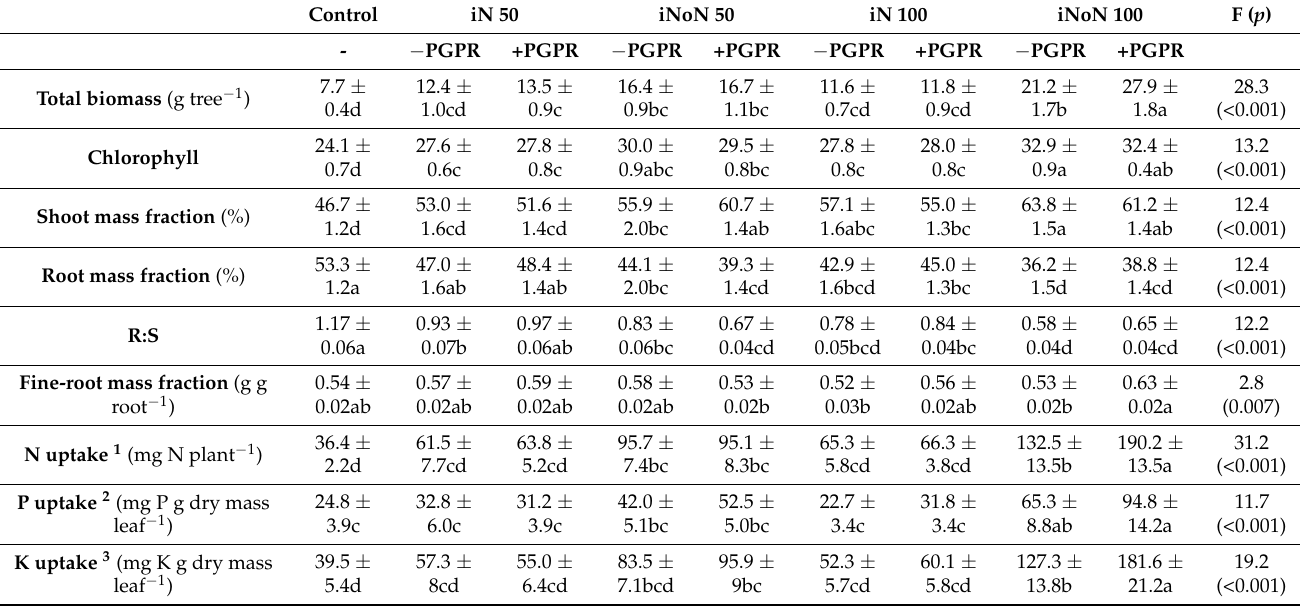
Shown are mean ( ± SE) values from 20 replicates per treatment, except for nutrient uptake which was obtained from 10 replicates per treatment. Different letters indicate significant differences among treatments (one-way ANOVA and Tukey’s post hoc tests, p < 0.05). 1 Nitrogen (N), 2 phosphorus (P) and 3 potassium